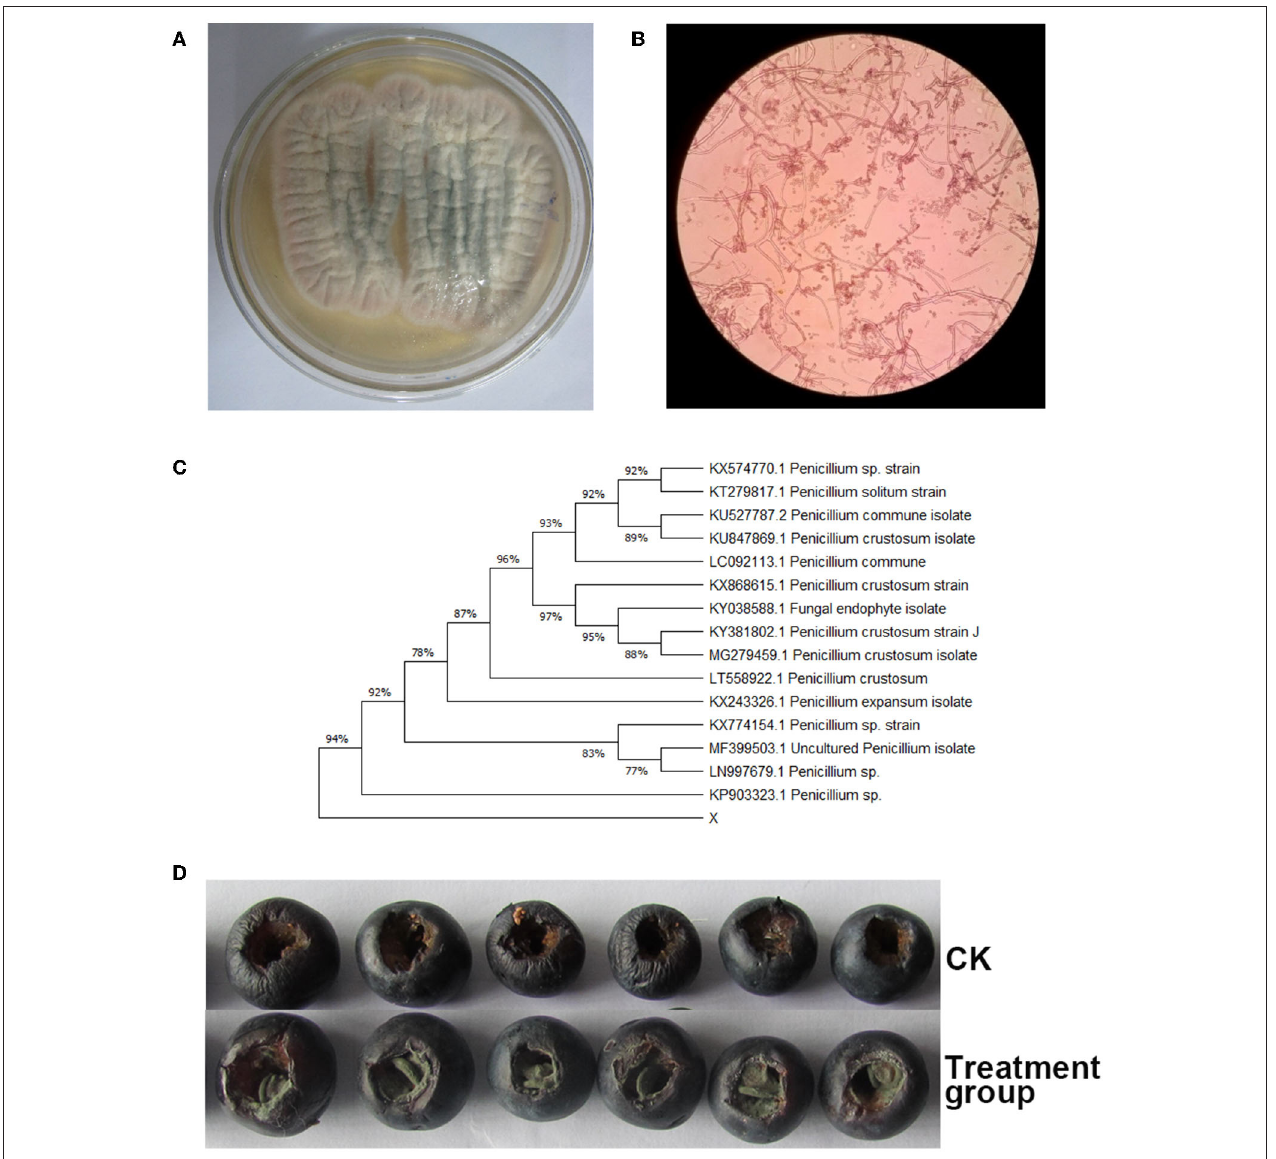
FIGURE 1 | Morphology of Y7 isolate cultures on PDA. (A) observe the surface of the colony, (B) structural characteristics of conidiophores, (C) UPGMA tree based on sequence analysis of internal transcribed spacer sequences, and (D) serious symptoms in pathogenicity tests.